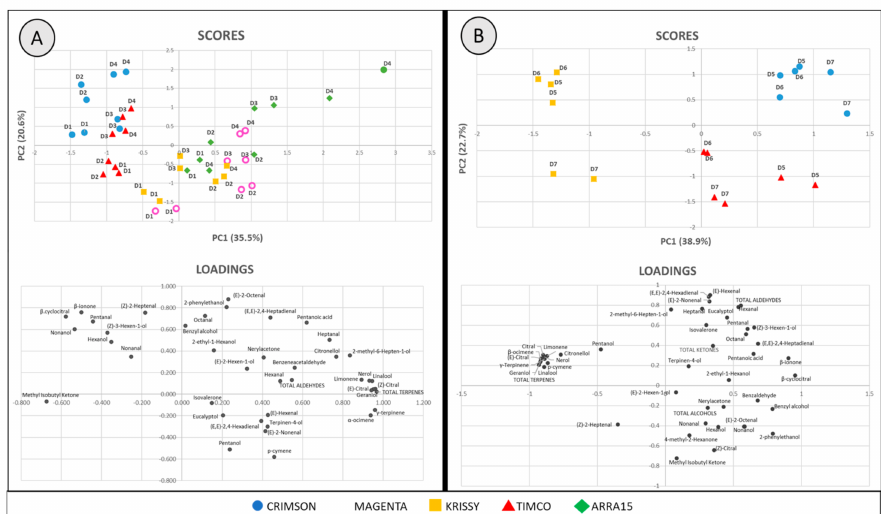
Figure 8. Data scores and loading biplots on the plane of the first two principal components (PC1 against PC2) of ( A ) table grapes along ripening: D1 , veraison; D2 , 12 DAV (days after veraison); D3 , 26 DAV; D4 , 37 DAV and ( B ) table grapes during storage: D5 , 54 DOS (days of storage); D6 , 75 DOS; D7 , 108